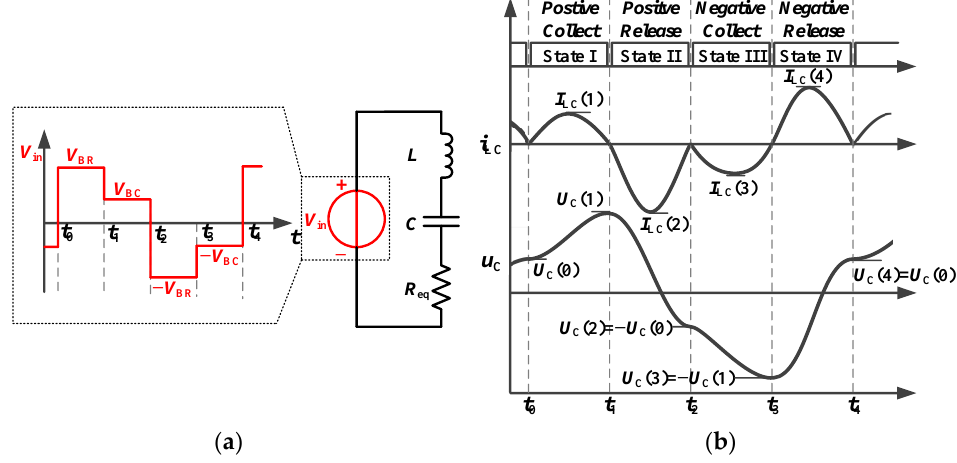
Figure 4. Theoretical waveforms of the proposed equalizer at V BR ≈ 3 V BC . ( a ) Equivalent input of the FBBELCC. ( b ) Waveforms including driving signals, inductor current i LC , and capacitor voltage u C of the equalizer.